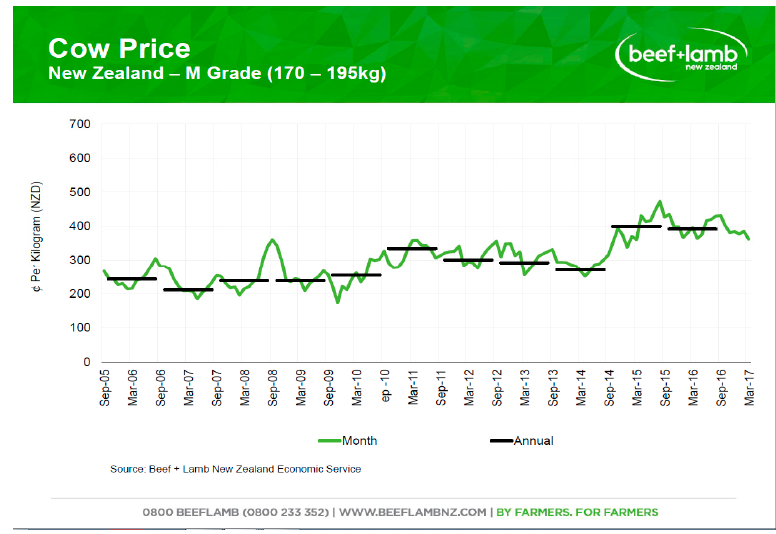
Figure 3. A 10-year movement in cow meat prices in New Zealand is shown [3].